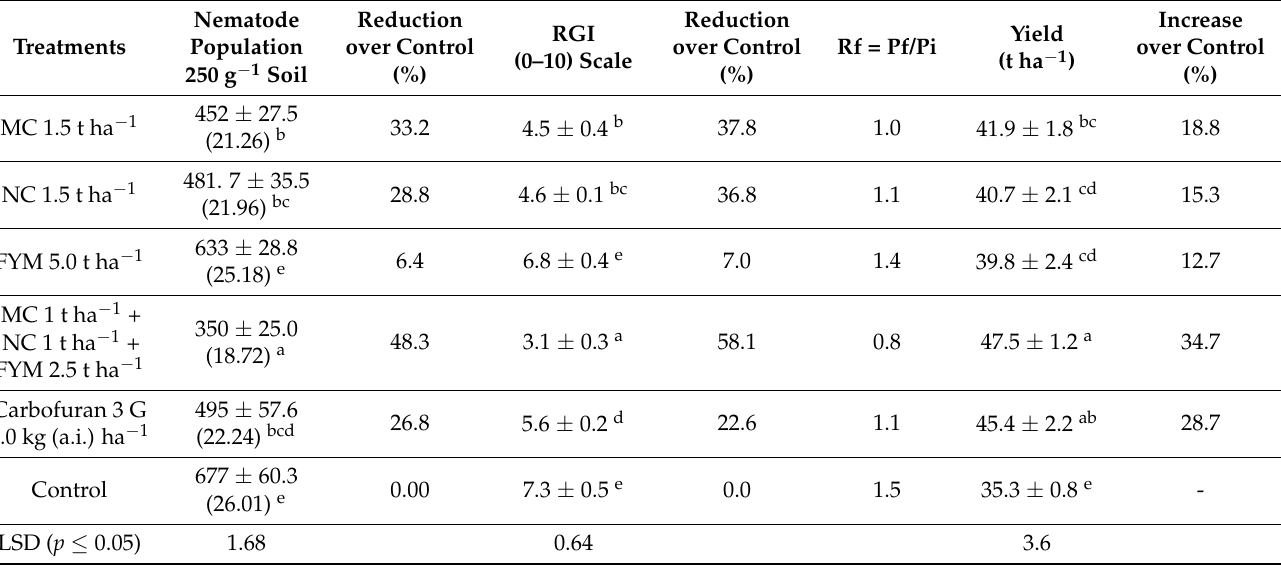
Table 3. Effects of different amendments on root-knot nematode infestation and yield of cucumber (var. Punjab Kheera 1) under protected conditions (polyhouse–I, Department of Plant